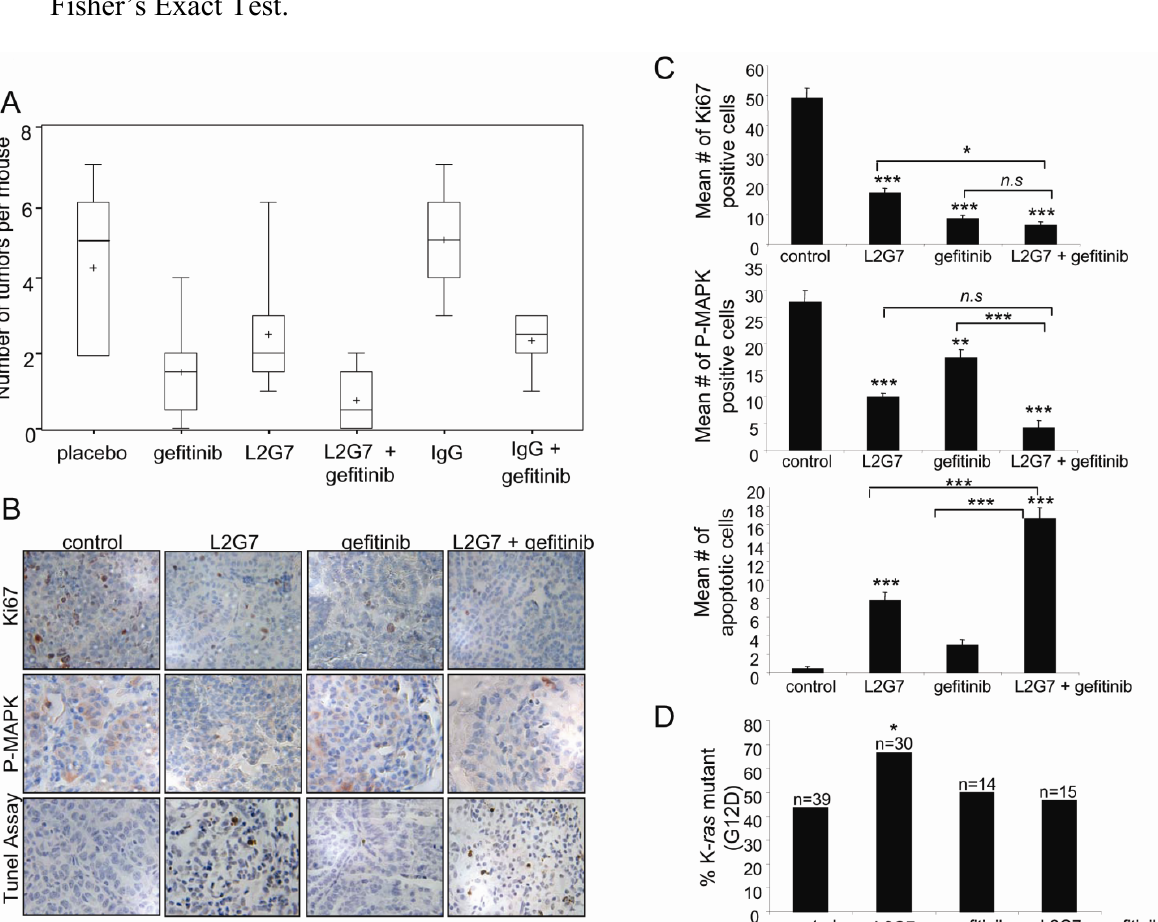
Figure 2. Tumor formation following NNK exposure in HGF transgenic mice treated with placebo, L2G7, gefitinib, or control IgG isotype-matched control antibody. ( A ) Boxplot of the number of tumors per mouse by treatment group. Line represents median and + represents the mean for each group. ( B ) Representative tumor sections from placebo control, L2G7, gefitinib and L2G7 + gefitinib treated animals showing immunohistochemical staining for Ki67, P-MAPK and apoptotic cells. ( C ) Quantitation for each marker was performed and results are presented as the mean ± SE number of positive cells for each marker from 5-high powered fields per experimental treatment. * P < 0.05; ** P < 0.01; *** P < 0.001 compared to control unless indicated, ANOVA. ( D ) Percentage of individual tumors containing a K- ras mutation. Control represents tumors isolated from placebo-treated and IgG-treated animals. Results analyzed using Fisher’s Exact